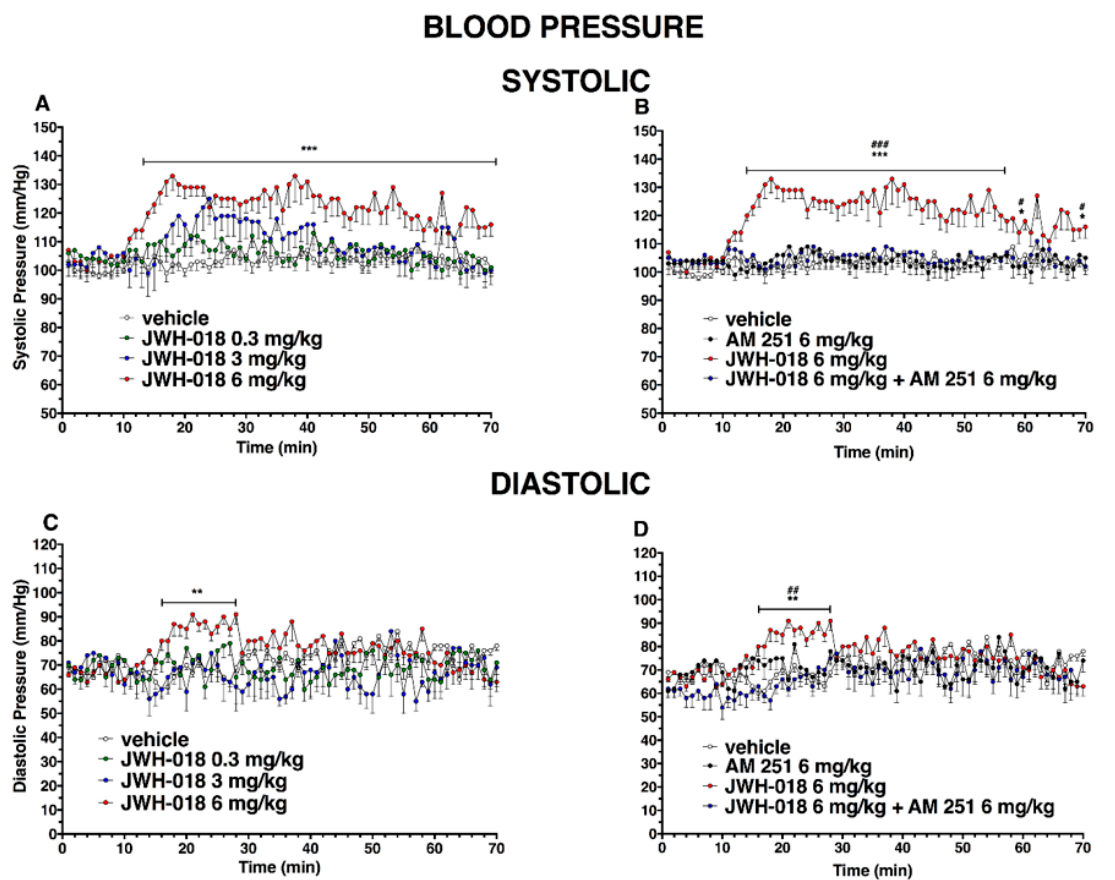
Figure 9 . Effect of systemic administration of JWH-018 (0.3–6 mg/kg on systolic (panel ( A )) and diastolic (panel ( C ))) blood pressure. Data are expressed as absolute values (mm/Hg) in the form MEAN ± SEM of 8 different evaluations for each group. Statistical analysis was performed by two- way ANOVA, followed by Bonferroni’s test for multiple comparisons. ** p < 0.01 *** p < 0.001 versus vehicle. Interaction of JWH-018 (6 mg/kg i.p) with the selective CB 1 receptor antagonist AM 251 (6 mg/kg, i.p.) on systolic (panel ( B )) and diastolic (panel ( D )) blood pressure. Statistical analysis was performed by two-way ANOVA, followed by Bonferroni’s test for multiple comparisons. * p < 0.05 ** p < 0.01 *** p < 0.001 versus vehicle, # p < 0.05, ## p < 0.01, ### p < 0.001 versus AM 251 + agonists.